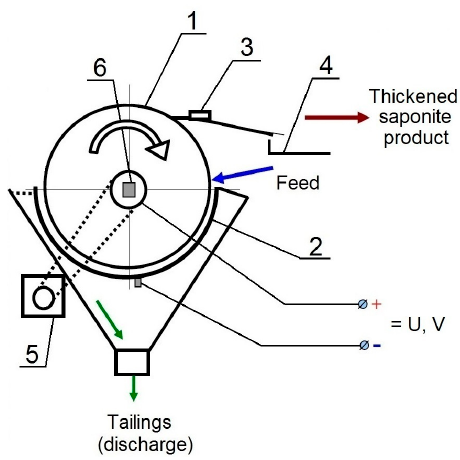
Figure 4. Schematic diagram of the electrochemical separator. 1—drum; 2—separating bath; 3—scraper; 4—chute; 5—engine; 6—current-collecting device.